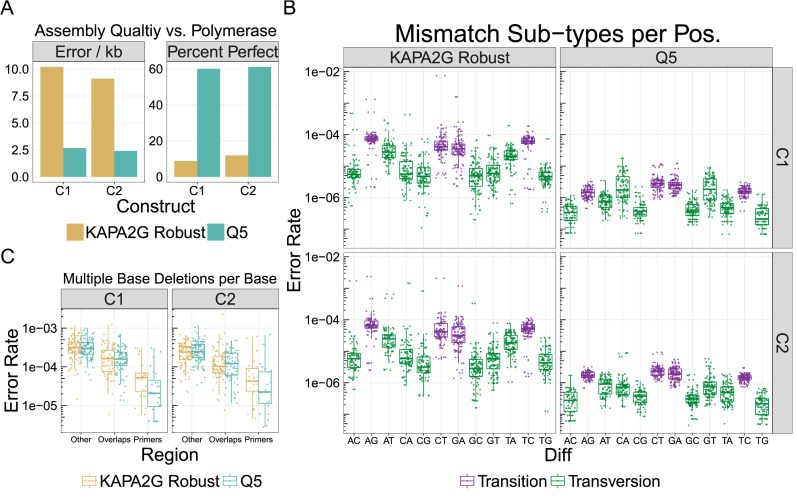
Effect of polymerase on assembly quality. We assembled two different 220 bp constructs (C1 and C2) from five 60 nt oligos with 20 bp overlaps with Q5 and KAPA2G Robust polymerases. (A) We find that the average error frequency of both constructs is significantly higher for KAPA2G Robust than for Q5 (9.7 versus 2.5 errors/kb). We observe similar trends for the average percentage of perfect assemblies (60.5% for Q5 and 10.4% for KAPA2G Robust). (B) Similar to the two-oligo assembly, we find that the Taq-based KAPA2G Robust polymerase also has a higher rate of transitions than transversions (mean of \documentclass[12pt]{minimal}
\usepackage{amsmath}
\usepackage{wasysym}
\usepackage{amsfonts}
\usepackage{amssymb}
\usepackage{amsbsy}
\usepackage{upgreek}
\usepackage{mathrsfs}
\setlength{\oddsidemargin}{-69pt}
\begin{document}
}{}$5.32\ \times \ {10^{ - 5}}$\end{document} versus \documentclass[12pt]{minimal}
\usepackage{amsmath}
\usepackage{wasysym}
\usepackage{amsfonts}
\usepackage{amssymb}
\usepackage{amsbsy}
\usepackage{upgreek}
\usepackage{mathrsfs}
\setlength{\oddsidemargin}{-69pt}
\begin{document}
}{}$6.40\ \times \ {10^{ - 6}}$\end{document} over both constructs; Mann–Whitney U, P << 0.001). (C) We find that the median rate of multiple base deletions per base in the overlap regions decreased ∼2-fold relative to non-overlapping regions for both polymerases (Mann–Whitney U, P << 0.001). Similarly, the median rate of multiple base deletions per base also significantly decreases in the priming regions for both KAPA2G Robust(∼6-fold) and Q5 (∼13-fold) for both constructs (both Mann–Whitney U, P << 0.001). The difference in decrease between the polymerases was not significant.